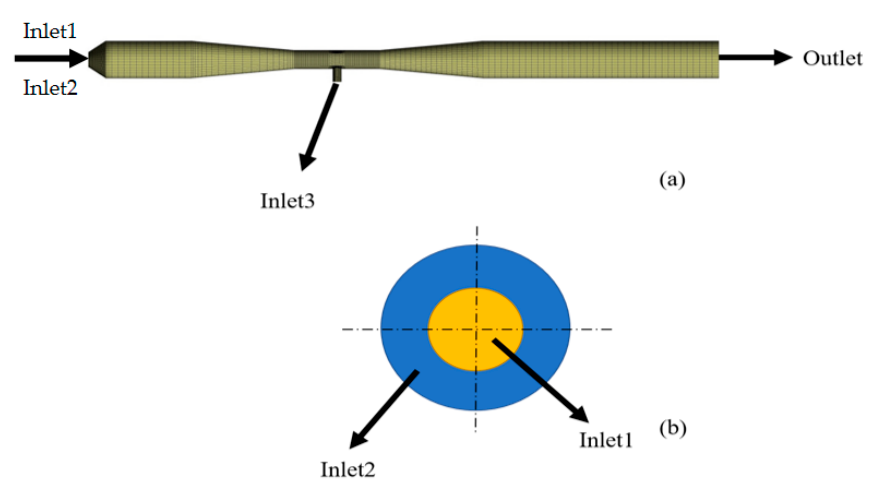
Figure 2. Mesh generation: ( a ) meshed reactor and ( b ) gas-phase velocity.